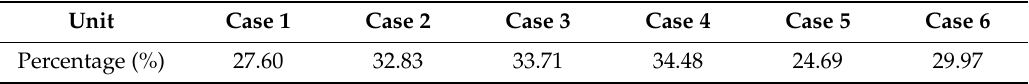
Figure 12. Dimensionless spatial velocity longitudinal velocity component Table 6. Increment of the spatial velocity in the main channel due to spur dike